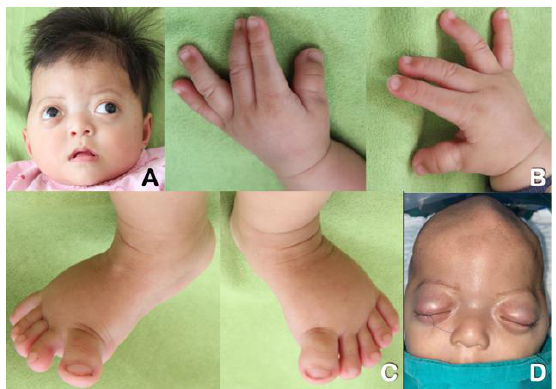
Figure 1. Twin A at age 6 months. ( A ) Brachydactyly, ocular proptosis, and depressed nasal bridge. ( B ) Brachydactyly and broad thumbs. ( C ) Broad great toes. ( D ) Preoperative view of the cranium. Note ridges at metopic and sagittal sutures as a result of synostosis.